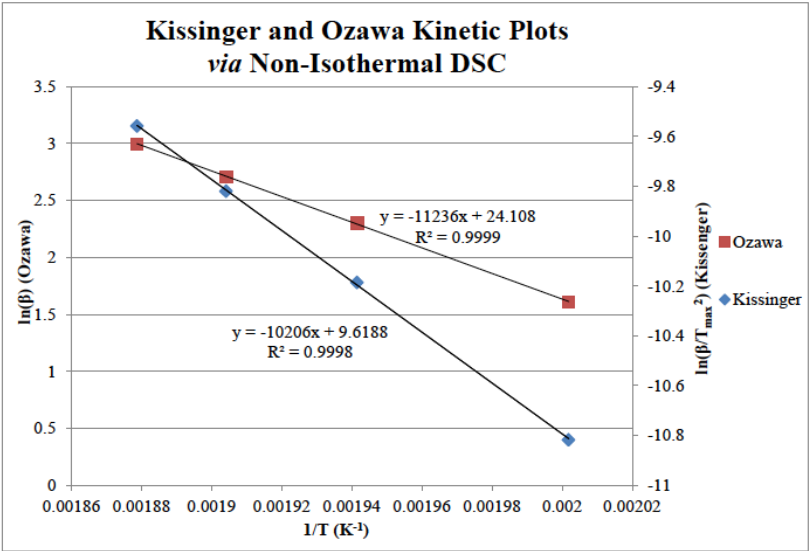
Figure 4. Kissinger and Ozawa plots for the polymerization of BA-a.